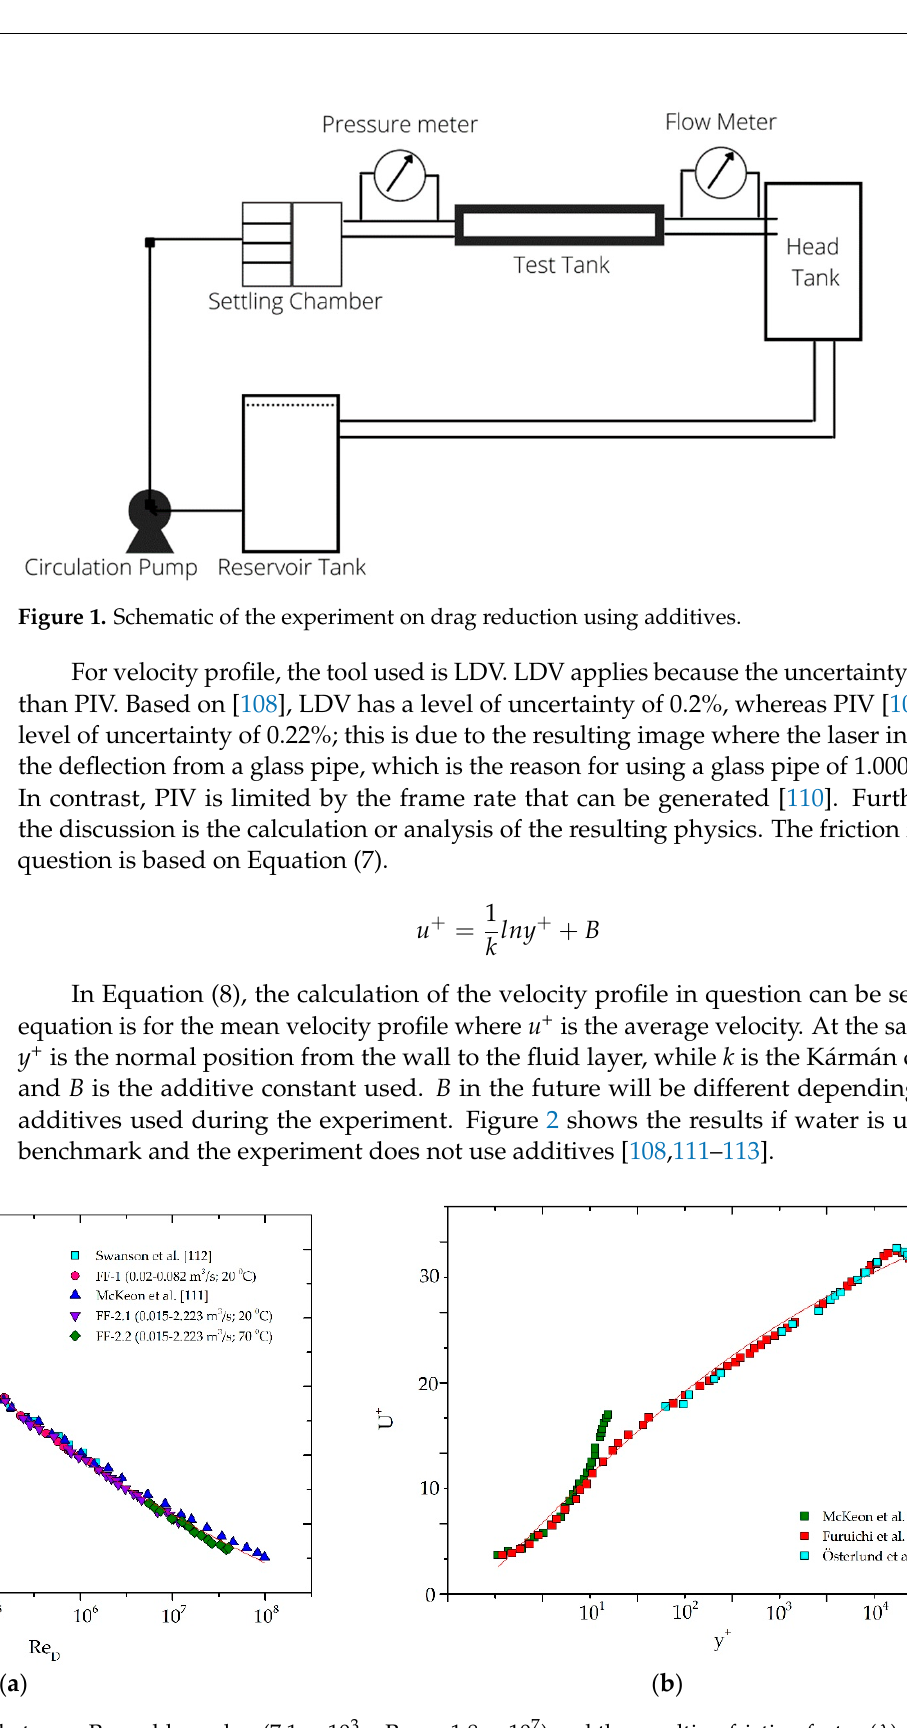
Figure 2. ( a ) Comparison between Reynold number (7.1 × 10 3 > Re D > 1.8 × 10 7 ) and the resulting friction factor ( λ ) = ( f ) at different temperatures. ( b ) Velocity profile formed in the inner layer.